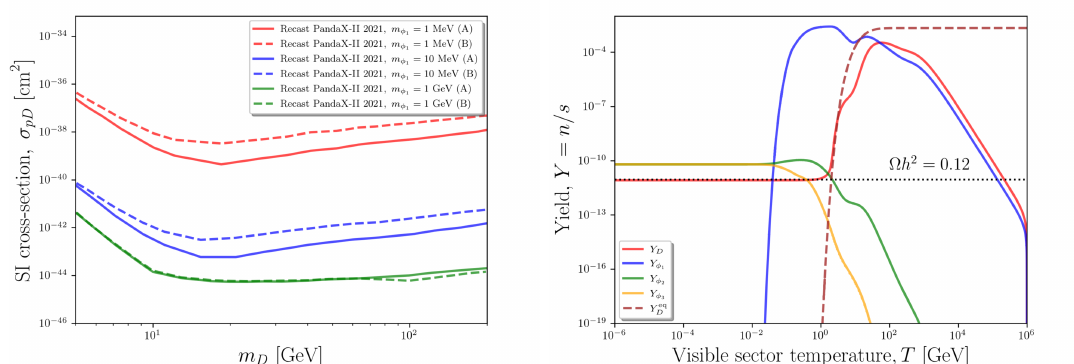
Figure 8. Left panel: a recast of the exclusion limits of the spin-independent proton-DM cross section, σ pD , given by the PandaX-II Collaboration [26] for our model with two sets of initial hidden sector constraints, i.e., case A with ξ i 0 = 1 (solid lines) and case B with ξ i 0 (cid:28) 1 (dashed lines) as a function of m D for three different values of the pseudo-scalar φ 1 mass, i.e., m φ =(1 MeV (red lines), 1 10 MeV (blue lines) and 1 GeV (green lines)). The coupling y D for each point is chosen to give the correct DM relic density. Right panel: a plot of the yield of the dark particle species with the input: m D = 48 GeV, m φ = 1 GeV, m φ = m φ = 1 MeV, y f = 10 − 7 , y D = 0 . 55 and κ 1 = κ 2 = 1 × 10 − 5 1 2 3